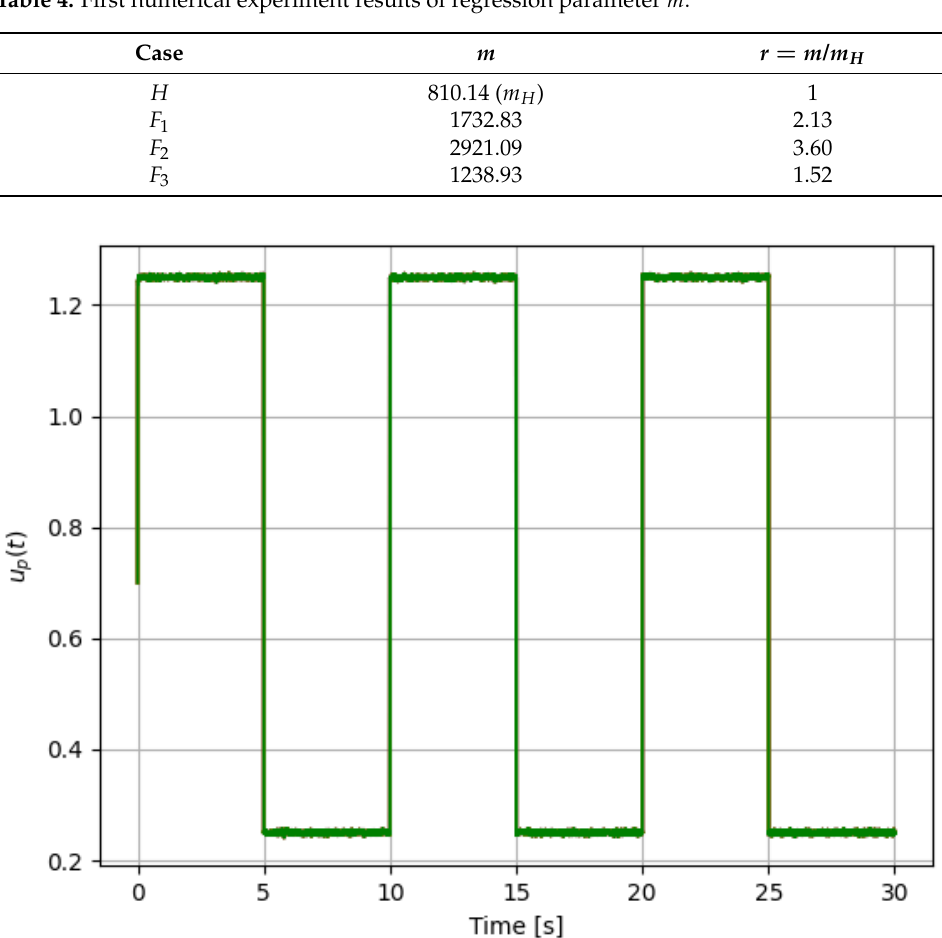
Figure 2. First simulation: pitch command signal for testing, where additive noise signal can be